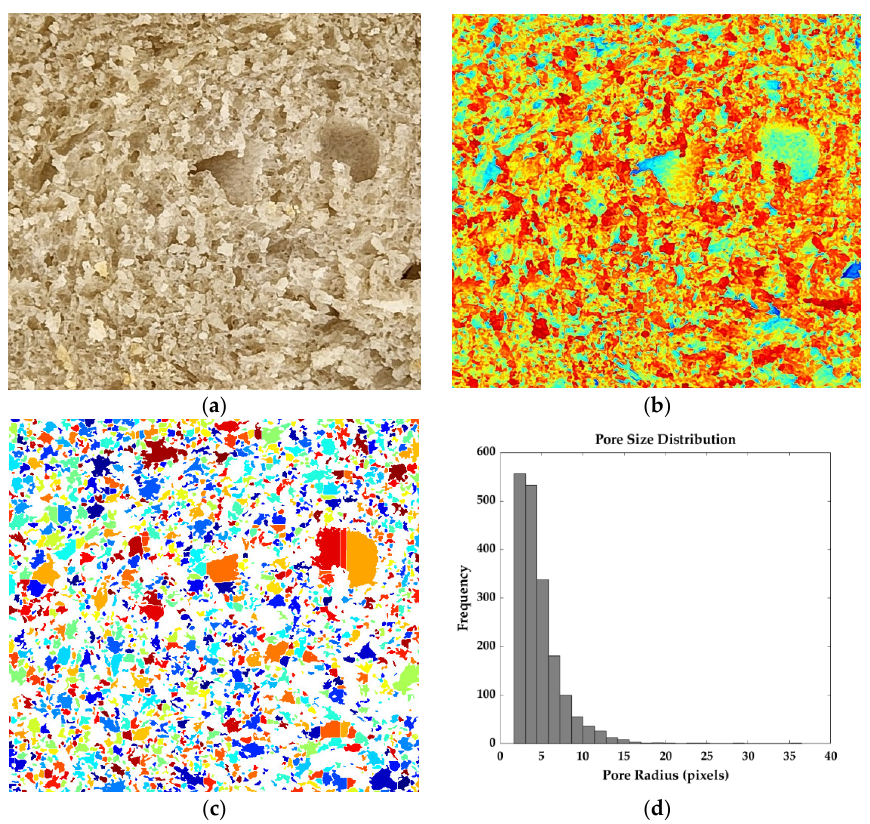
Figure 2. Images of the computer vision analysis to assess porosity and air spaces of the sourdough bread slices, where ( a ) original image, ( b ) depth map, ( c ) pore space segmentation, and ( d ) histogram of the pore size